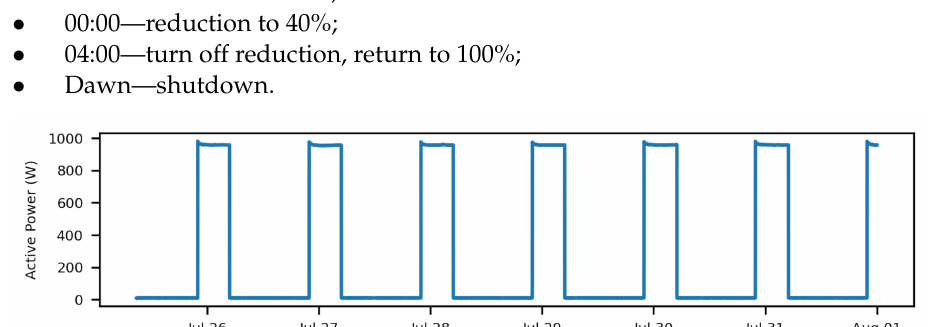
Figure 3. Graph of the active power of one phase for lamps without reduction.